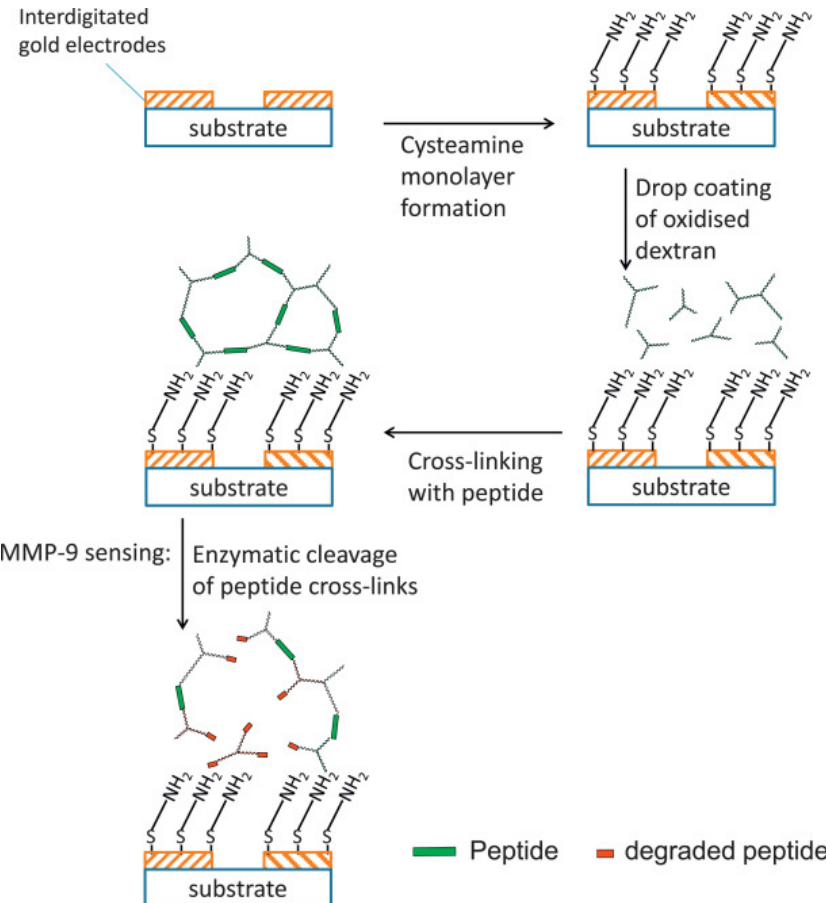
Figure 4. Schematic of sensor fabrication and the sensing process. Reprinted from Reference [61] with permission from Elsevier. License Number: 5156040634380.